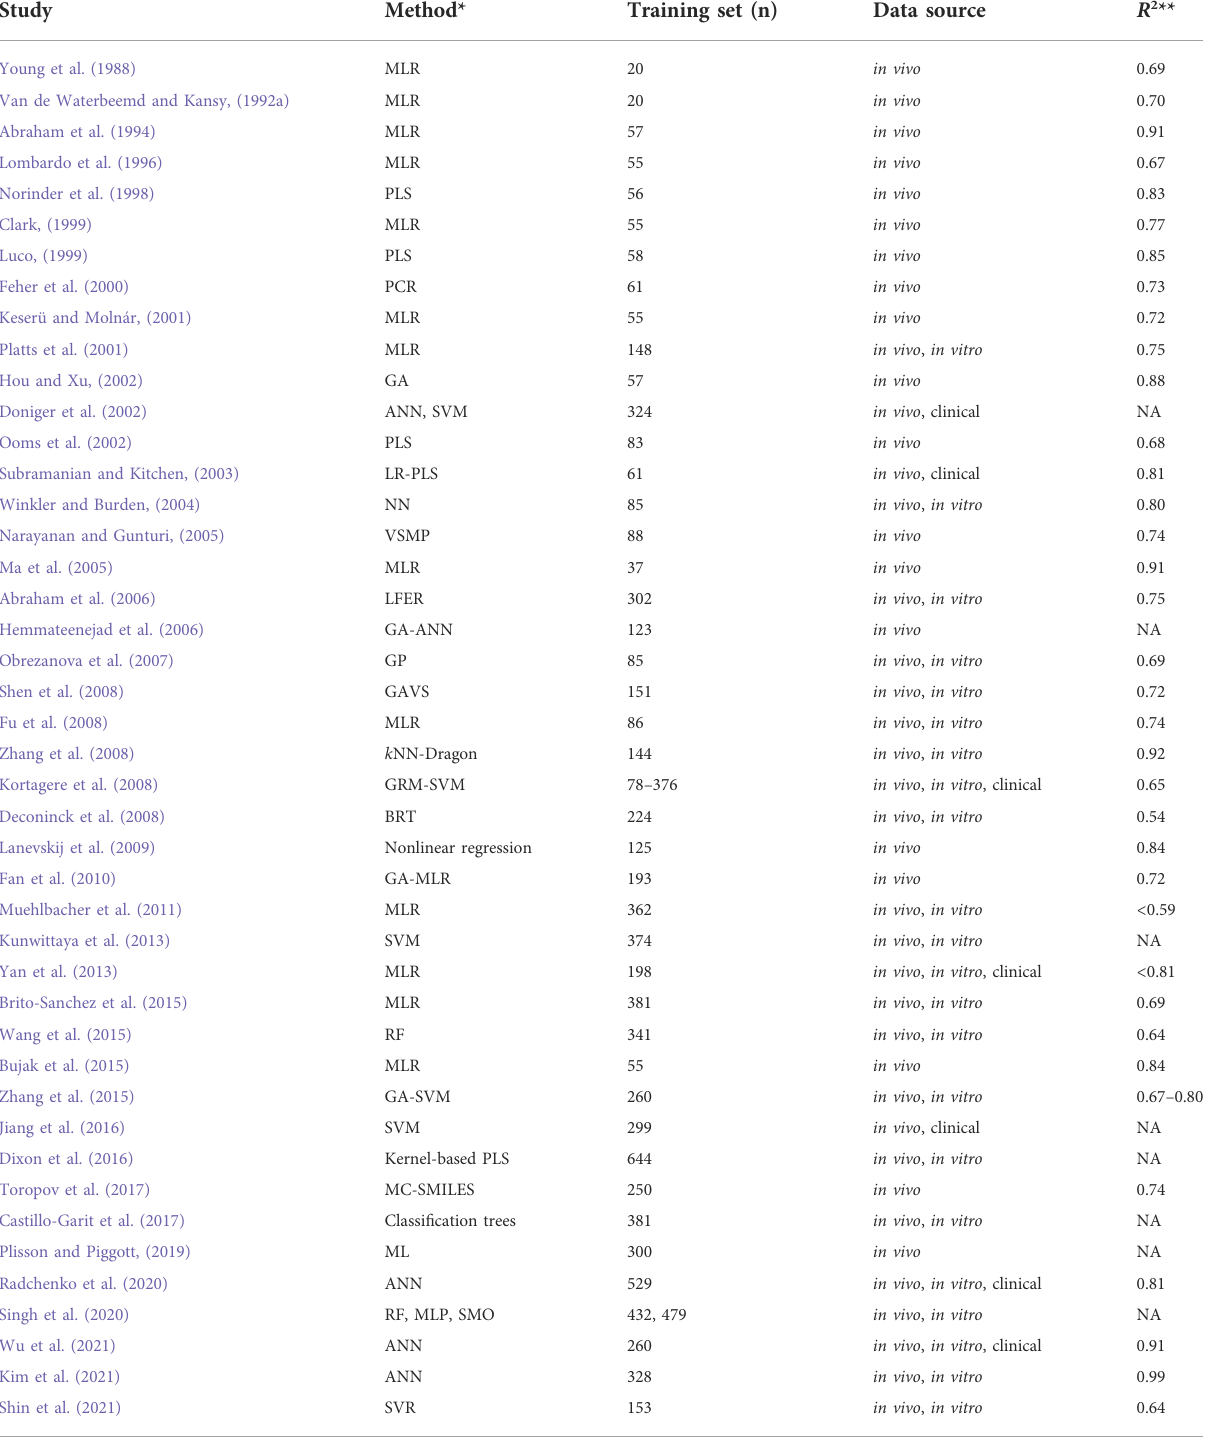
TABLE 1 Summary of previously published models and data sets used for log BB